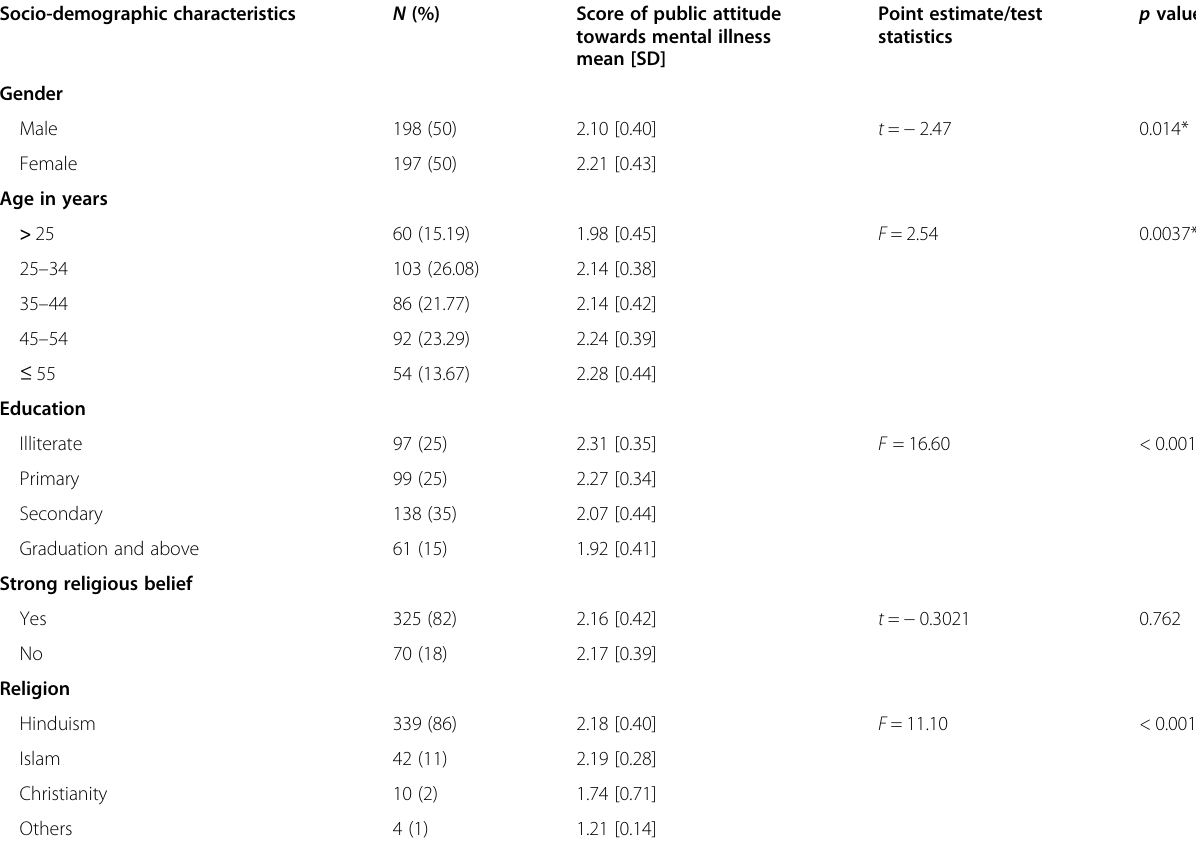
Table 1 Association of public attitudes towards mental healthcare facilities and socio-demographic characteristics Socio-demographic